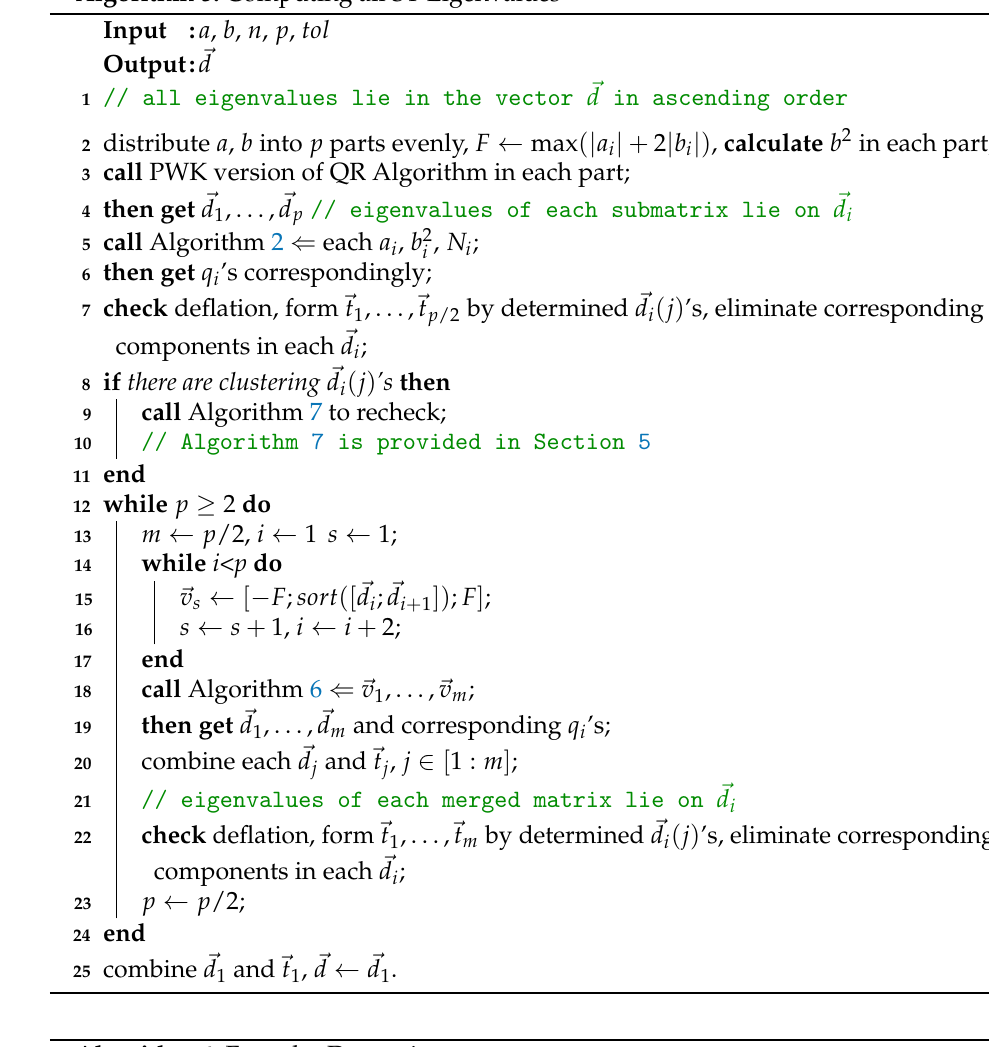
Algorithm 6: Fzero by